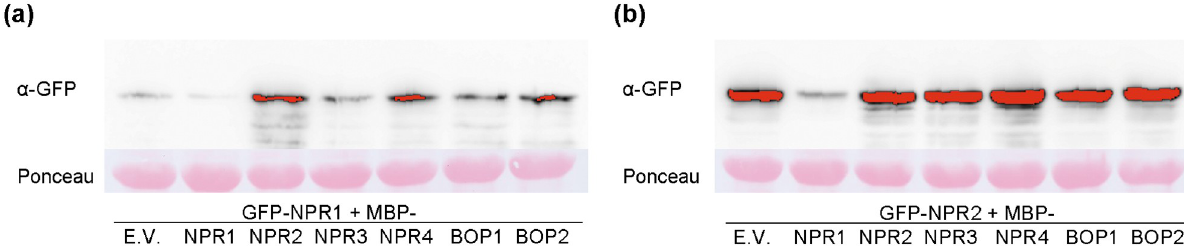
Fig 8. Stability of NPR1 and NPR2 in the presence of the NPR1 paralogs. (a) Stability of GFP-NPR1 when co-expressed with the NPR1 paralogs fused to MBP. The constructs were agroinfiltrated with 1mM SA treatment one day before sampling. (b) Stability of GFP-NPR2 when co-expressed with the NPR1 paralogs, as in (a). Ponceau-S staining is shown below as a loading